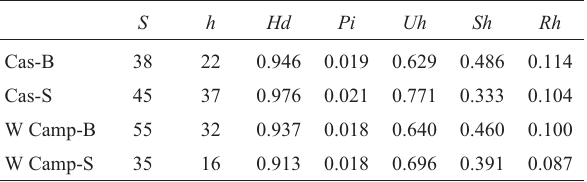
Table3 -Estimatesofgeneticdiversityamongsamplesanalysed. S :segre- gating sites; h : number of haplotypes; Hd : haplotype diversity; Pi : nucleo- tide diversity; Uh : frequency of unique haplotypes per total number of haplotypes; Sh : frequency of individuals with shared haplotypes; Rh : fre- quency of haplotypes observed in more than one individual.